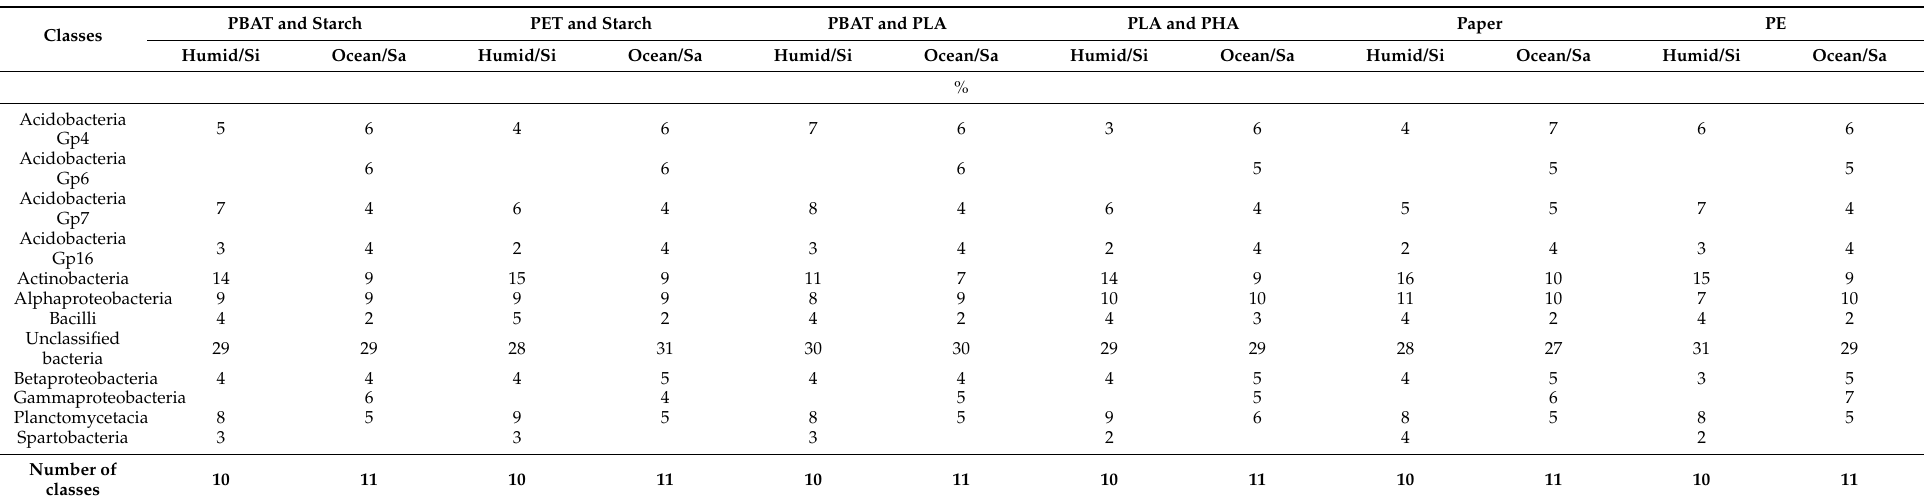
Table 2. Populations of bacteria, expressed as percentages and divided by classes, found in the soil under different mulches and in two locations. Humid/Si: location with humid subtropical climate (Cfa, according to the Köppen classification) and silt loam soil. Ocean/Sa: location with temperate oceanic climate (Cfb, according to the Köppen classification) and sandy loam soil. Values below 1% were excluded. Adapted from Bandopadhyay et al.